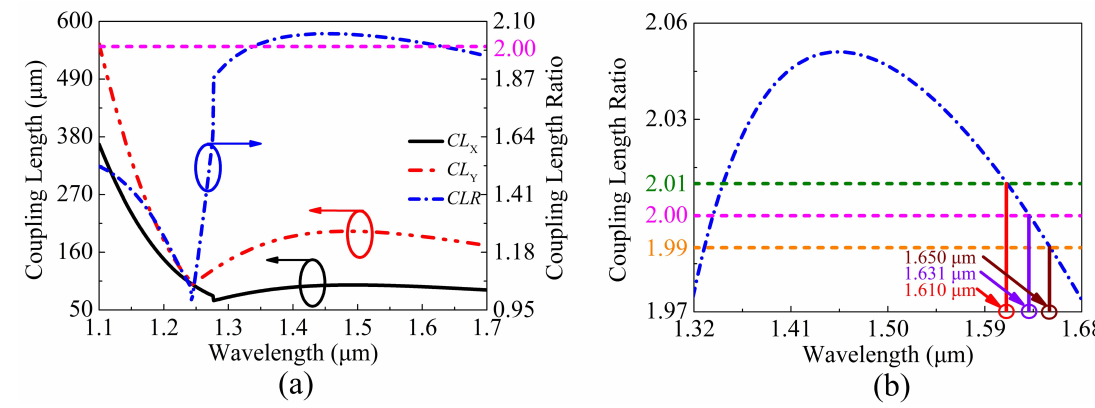
Figure 10. The optimal CL X , CL Y , and CLR of the proposed V-DC-PCF PBS, and ( b ) the zoomed flat region of the CLR